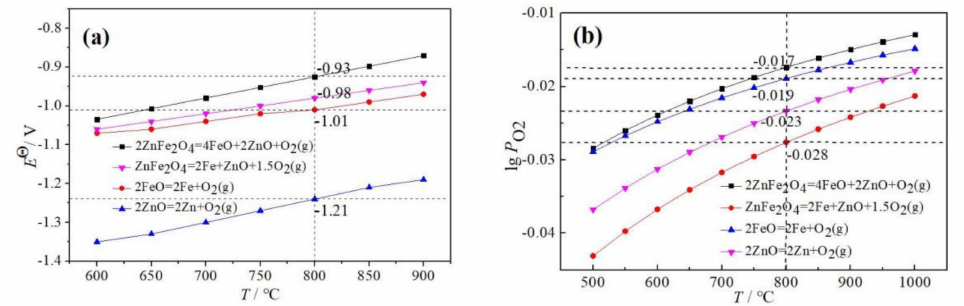
Figure 3. ( a ) The relationship between the theoretical decomposition voltage and temperature of ZnFe 2 O 4 , ( b ) the relationship between the oxygen partial pressure and temperature of ZnFe 2 O 4 .